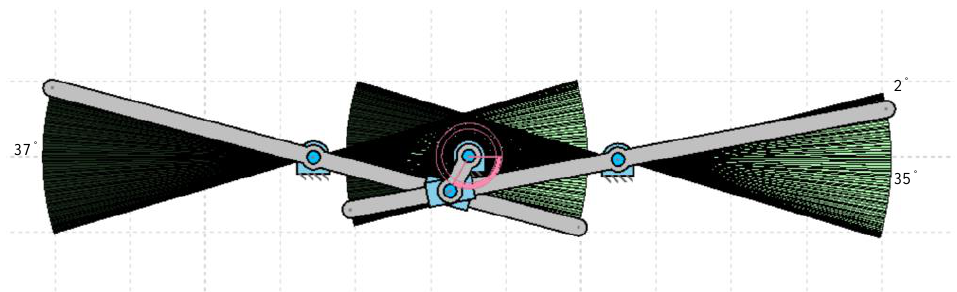
Figure 8. Workspace of the modeled SC-SDL design mechanism-II.